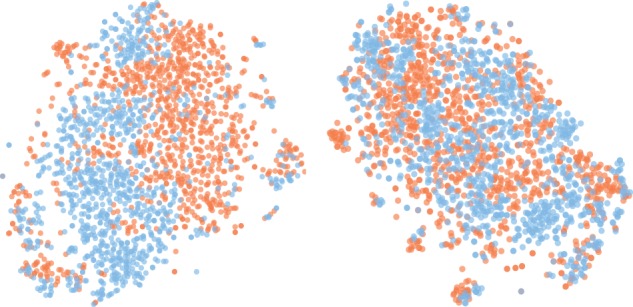
t-SNE embeddings of encodings from autoencoder (left) and DAA (right), with cell lines distinguished by color, and mean silhouette scores of 0.11 and 0.01, respectively